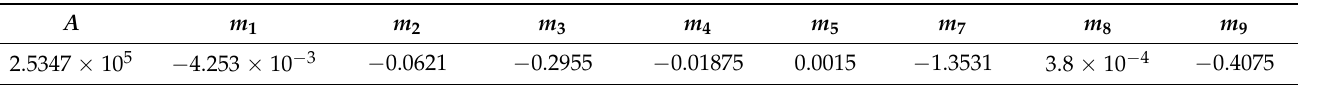
Figure 9. Flow chart of solving optimal parameters of material constitutive model by using adaptive simulated annealing algorithm. Table 2. Hansel–Spittel model parameters identified by reverse